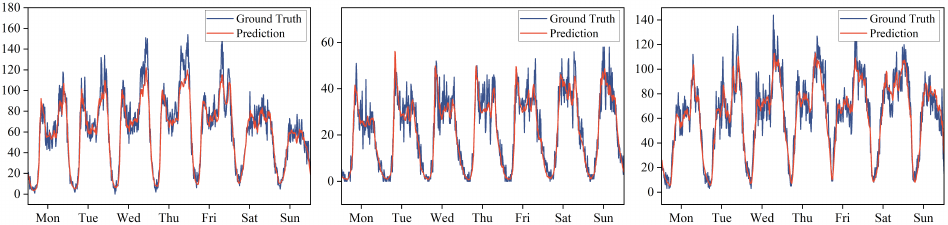
Figure 11. Visualization of travel demand for one week in three regions on NYC-taxi-2016(6/13-6/19).